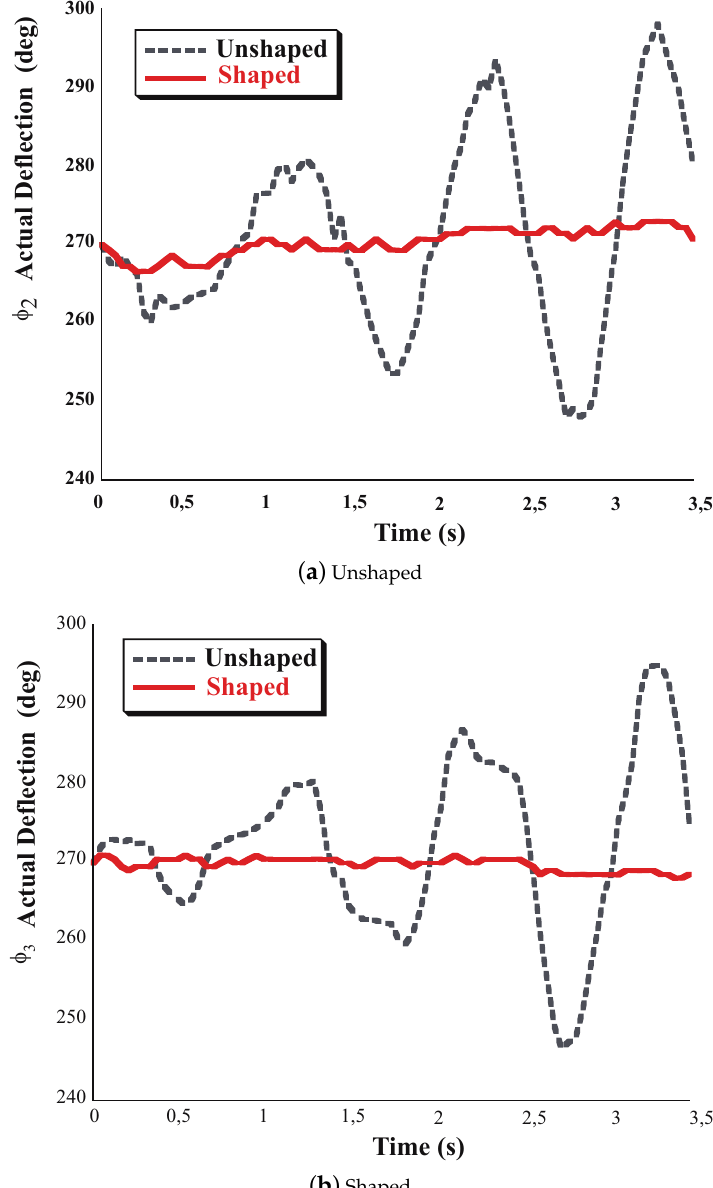
Figure 26. Unshaped and Direct SI-Shaped Experimental Responses of the Hydraulic crane under slewing motion. Conditions: sampling frequency 60